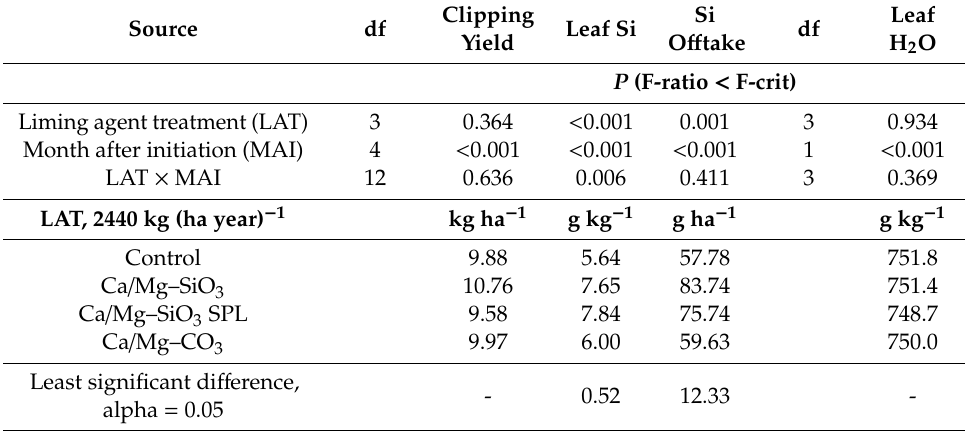
Table 3. ANOVA of creeping bentgrass fairway shoot growth/vigor, leaf Si accumulation, and leaf H 2 O status with separation of experiment-wide means where main effects were significant. Source df